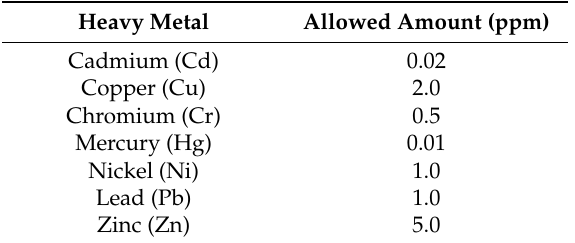
Table 1. Limit values for toxic elements and harmful substances in waste-water for agricultural use according to the current Hungarian legalization (Government Regulation 50 / 2001.